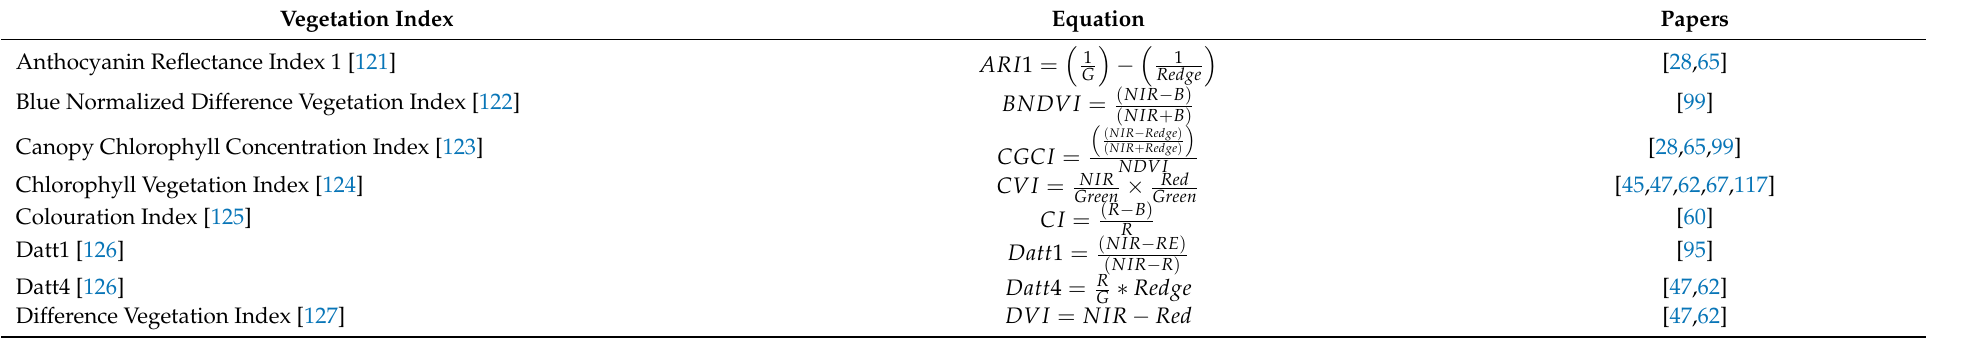
Table A4. Biomass indices used in the papers assessed in this